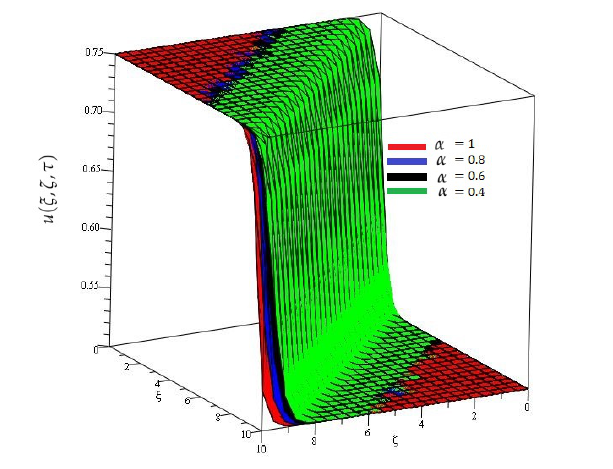
Figure 3. The numerical solution graph of u ( ξ , ζ , τ ) of Example 1 at different value of α .